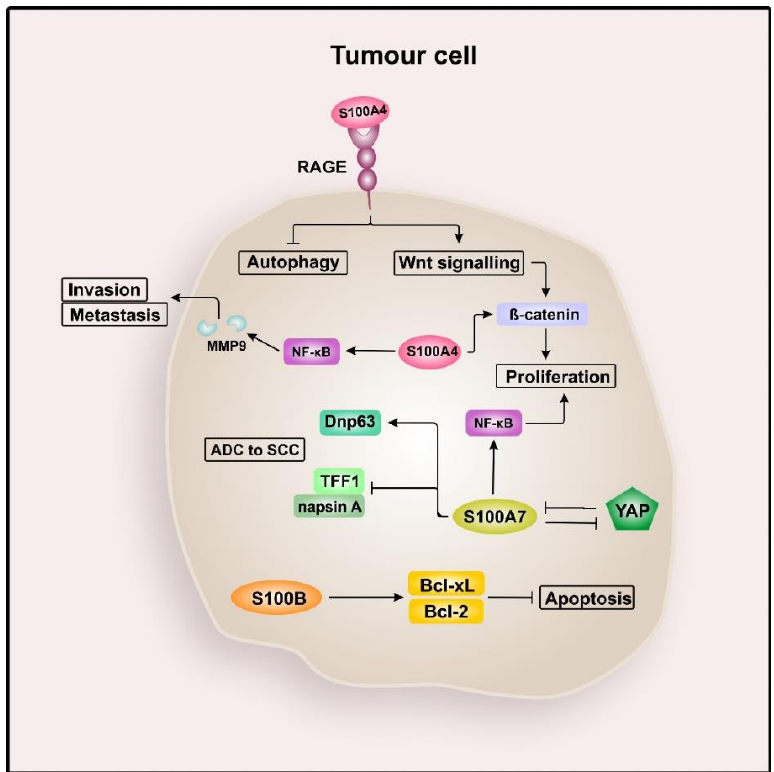
Figure 2. S100 signalling in lung cancer. Extracellular S100A4 inhibits autophagy and induces Wnt signalling by interacting with the receptor for advanced glycation end products (RAGE) and intracellular S100A4 additionally activates β-catenin, resulting in increased proliferation and enhanced viability of lung cancer cells. S100A4 also induces the expression of (MMP9) by activating nuclear factor “kappa-light-chain-enhancer” of activated B-cells (NF-κB), thereby promoting invasion and metastasis. S100A7 is most likely involved in adenocarcinoma (ADC) to squamous cell carcinoma (SSC) transdifferentiation of lung cancer cells, by upregulating the SSC marker DNp63 and downregulation of the ADC markers thyroid transcription factor 1 (TTF1) and aspartic proteinase napsin (napsin A). In this context, an inverse correlation of S100A7 and yes-associated protein (YAP) was observed. Moreover, S100A7 seems to activate NF- κ B-dependent cell proliferation. Within lung cancer-derived brain metastasis cells, S100B was shown to upregulate the expression of B-cell lymphoma 2 (Bcl-2) and B-cell lymphoma extra-large (Bcl-xL), indicating that S100B is capable of suppressing